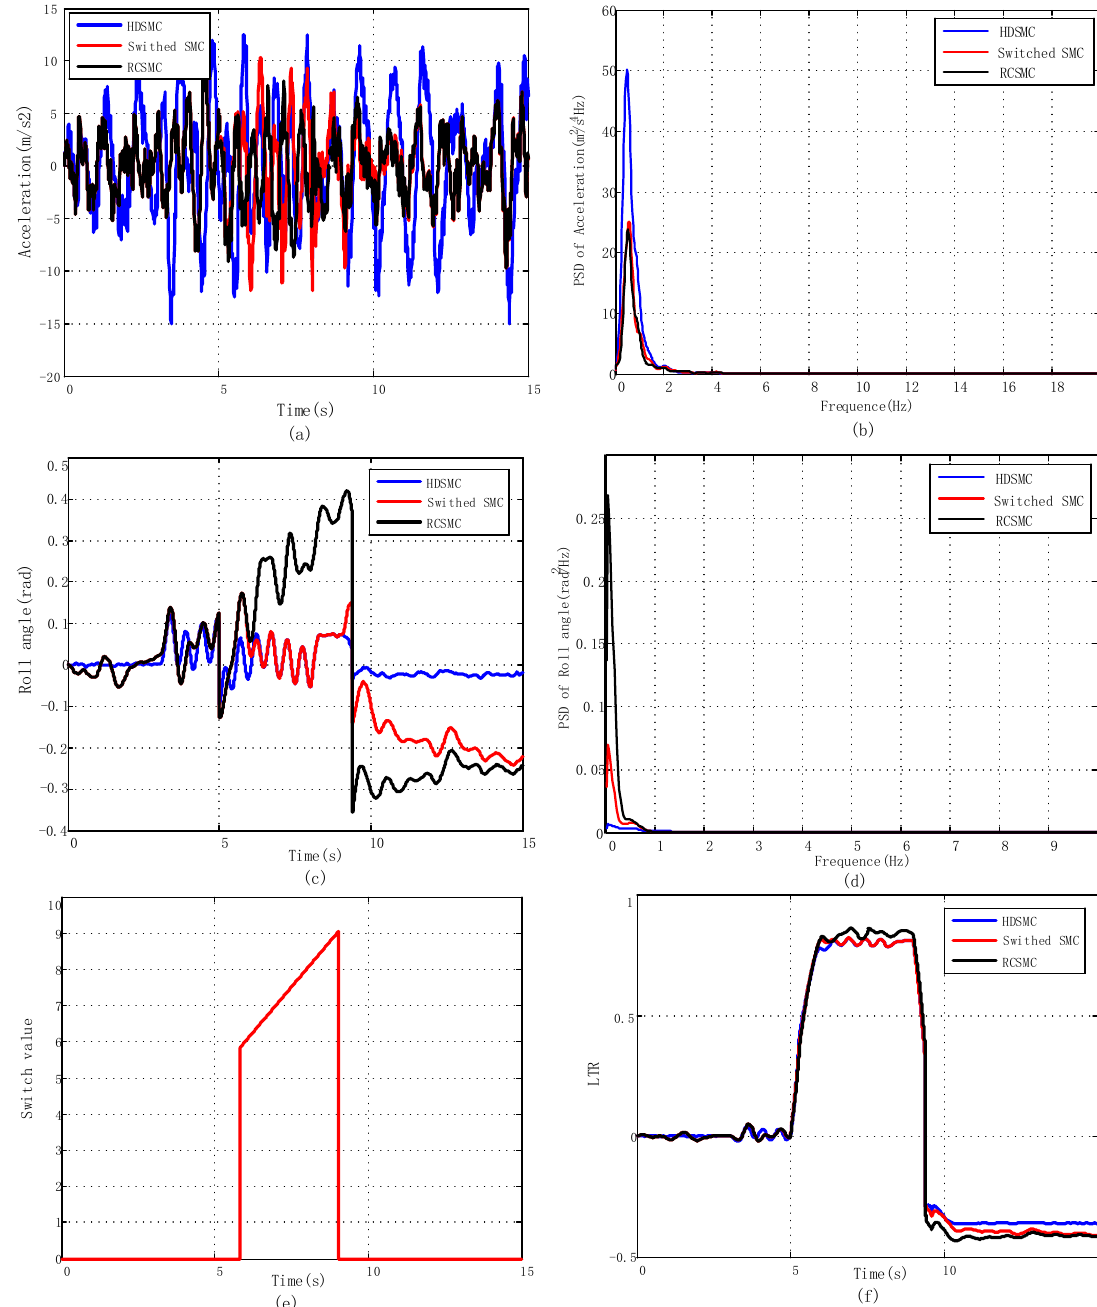
Figure 25. The rescue vehicle dynamic response based on the switch strategy under the bump road and the fishhook maneuver: ( a ) the vehicle body vertical acceleration in time domain; ( b ) the roll angle acceleration in time domain; ( c ) the vehicle body vertical acceleration in time domain in frequency domain; ( d ) the roll angle acceleration in frequency domain; ( e ) the switch value; ( f ) the LTR.